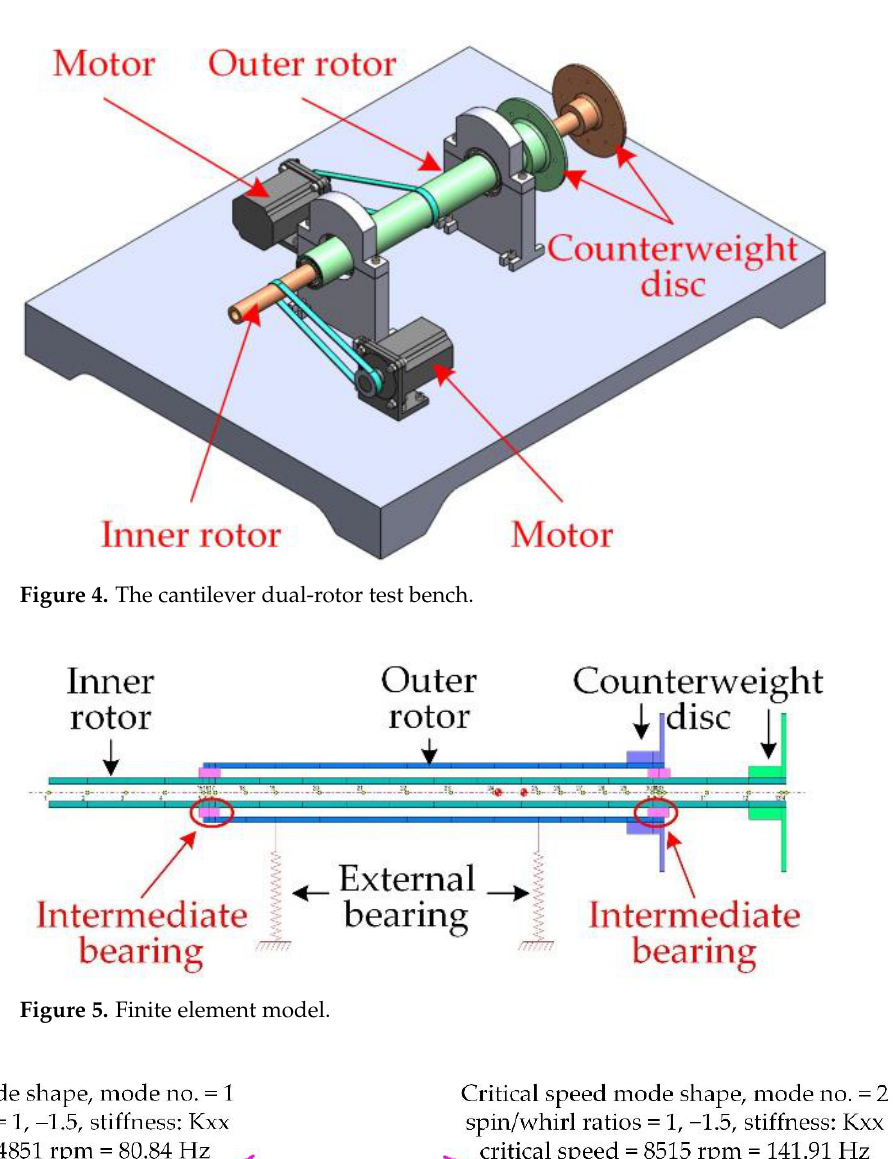
Figure 5. Finite element model.